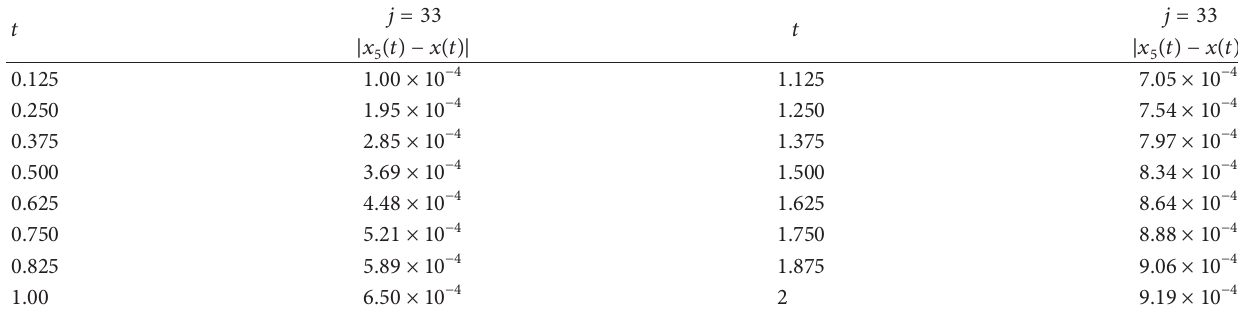
Table 3: Absolute errors for Example 3.